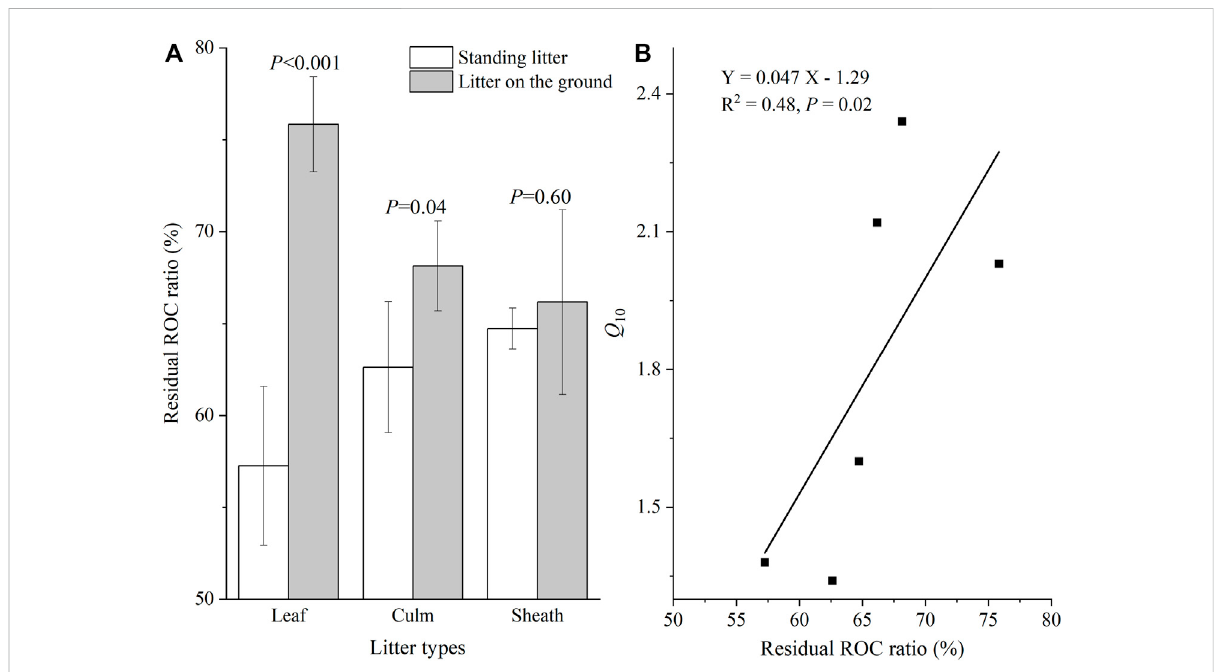
FIGURE 5 Recalcitrant organic carbon (ROC) residual ratio (A) and its relationship with the Q 10 value (B) .